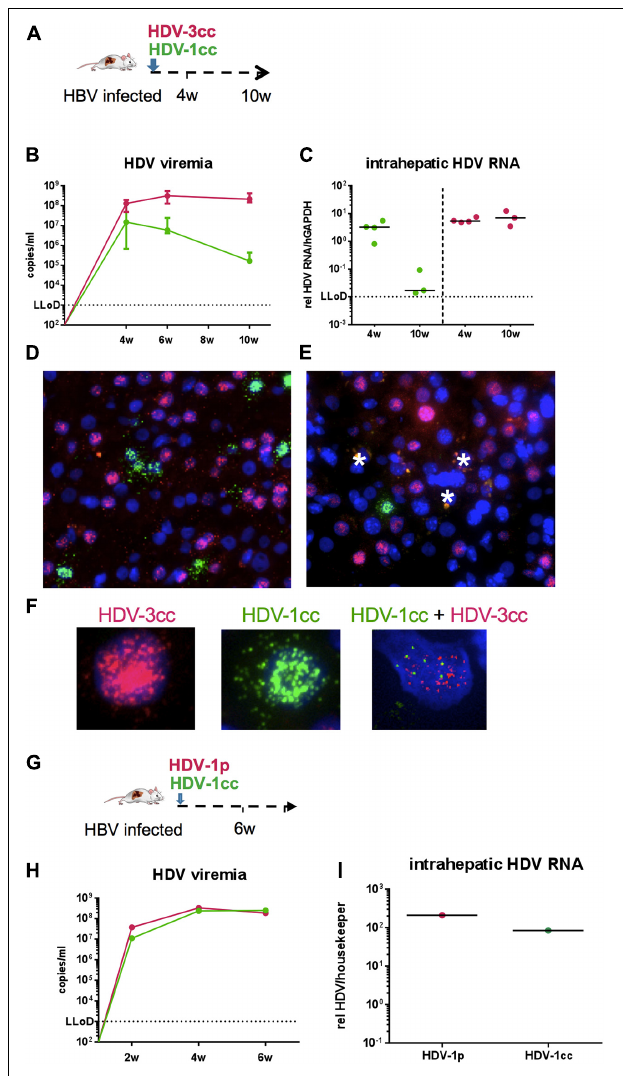
FIGURE 4 | HDV in chronic HBV-infected mice simultaneously super-infected with HDV-1cc and HDV-3cc or with HDV-1cc and HDV-1p. (A) Experimental setting of HDV-1/HDV-3 double infection. (B,C) qRT-PCR measurements (genotype specific HDV primers/probe for HDV-1 and HDV-3 were used) of serum HDV RNA (quantification with cell culture derived RNA standard) at different time-points (B) and liver HDV RNA (normalized to housekeeping gene hGAPDH) 4 and 10 weeks post super-infection with HDV (C) . Results are expressed as median ± range (B) , the bar shows median levels (C) . HDV-1cc RNA levels are depicted in green (line or dots) and HDV-3cc RNA levels in red (line or dots). (D,E) RNA in situ hybridization (RNAScope) staining of HDV-1cc (green) and HDV-3cc AG HDV RNA (red) in HDV-1cc/HDV-3cc-infected mice 4 weeks (D) and 10 weeks (E) post super-infection. Phagocytic remnants have an autofluorescence and are marked with a white star. (F) Examples of HDV-3cc AG (red, left), HDV-1cc AG (green, middle), and HDV1/3 AG double positive human hepatocytes in mice infected with both HDV genotypes. Nuclei are stained with dapi (blue). (G) Experimental setting of HDV-1cc/HDV-1p double infection. (H,I) qRT-PCR measurements (strain specific HDV primers/probe for HDV-1cc and HDV-1p were used) of serum HDV RNA (quantification with cell culture derived RNA standard) at different time-points (H) and liver HDV RNA (normalized to housekeeping gene hGAPDH) 6 weeks post super-infection with HDV (I) . HDV-1cc RNA levels are depicted in green (line or dots) and HDV-1p RNA levels in red (line or